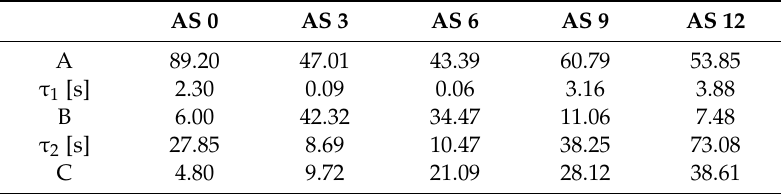
Figure 13. Transmission profiles for additive solutions containing 0–12% additive and for the PESU Dope solution. All measurements were carried out at room temperature. Table 4. Fit parameters for results of the transmission experiments .